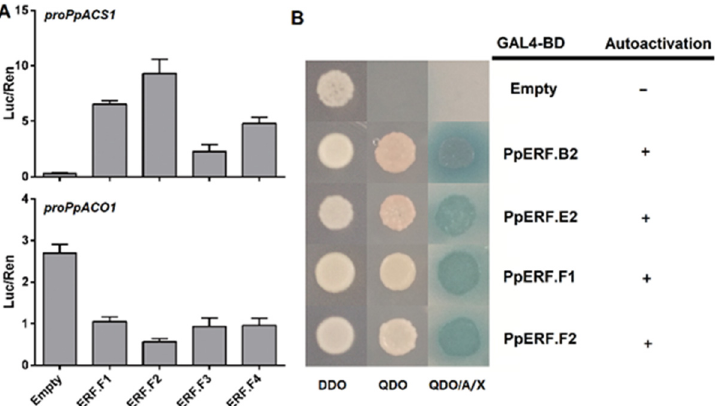
Figure 6. Functional analysis of group F ERFs. ( A ) Assay of the activation of group F ERFs on the promoter of PpACS1 and PpACO1 using the dual luciferase assay. Empty vector was used as the control. The error bars show SE of four biological replicates. ( B ) Auto-activation activity test of PpERFs in yeast. The yeast was grown on three medium Minimal Media Double Dropouts (DDO), Minimal Media Quadruple Dropouts (QDO), and QDO with Aureobasidin A and X-a-Gal (QDO / A / X), corresponding to SD-Trp, SD-Trp-His-Ade, and SD-Trp-His-Ade + ABA + X- α -Gal, respectively.